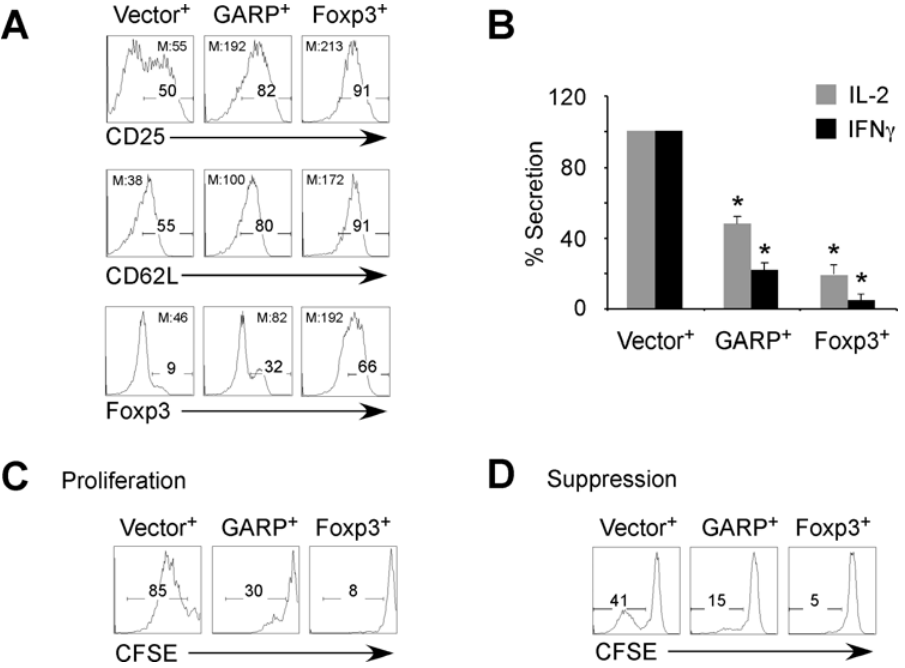
Figure 2. Ectopic expression of GARP endows T N cells with partial T reg phenotype and function. ( A ) GARP-transduced cells express higher levels of CD25 and CD62L, and upregulate Foxp3 at a greater level after TCR stimulation than the control vector-transduced cells. Cells were transduced and expanded for two weeks before staining for CD25 and CD62L. RFP + cells were then sorted and re-stimulated by DC plus SEB at suboptimal conditions before staining for Foxp3. Vector + , control vector-transduced T N cells; GARP + , GARP-transduced T N cells; Foxp3 + , Foxp3- transduced T N cells. M, Geometric mean. Data are representative experiments from at least three different donors. ( B ) GARP-transduced cells produce reduced levels of cytokines. Cytokine production in the supernatant of the activation culture was measured using CBA and data are shown by first normalizing the control geometric mean to be 100%. Range of control production (pg/ml): IL-2, 300–1000; IFN c , 3000–10000. Data represent the mean 6 SEM of experiments from at least three different donors. *, P , 0.05, n $ 3; experimental versus control. ( C ) GARP-transduced cells exhibited impaired proliferative capacity and ( D ) intermediate suppressive activity. Data are representative experiments from at least three different healthy human